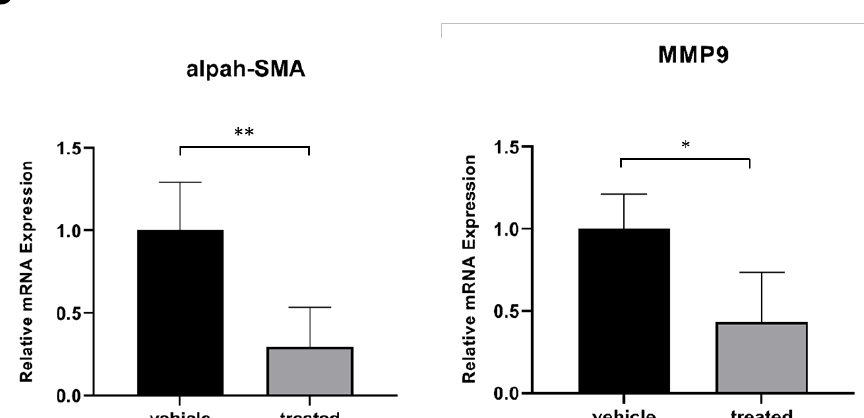
Figure 7. Assessment of gene expression by quantitative RT-PCR. ( A ) primer sequences used for quantitative RT-PCR shown in B and Figure 6D. ( B ) Expression levels of α -SMA and MMP9 in livers of indicated groups (*, p < 0.05; **, p < 0.01).